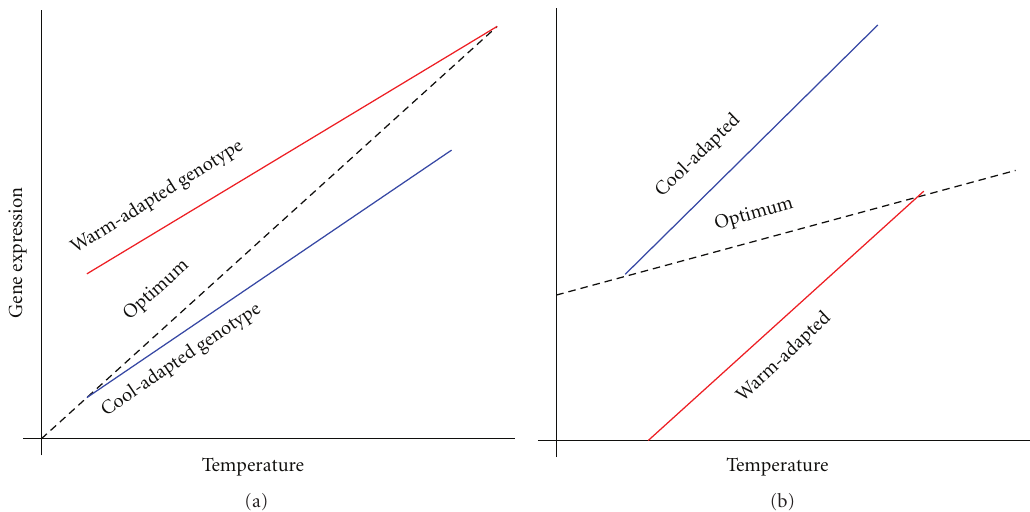
Figure 3: Adaptive and nonadaptive reaction norms. These hypothetical examples suppose that the optimum expression level for some gene increases with temperature and that increased temperature induces increased expression of the gene. (a) Plasticity is adaptive when it keeps expression closer to the optimum than it would be if expression, were constant across temperatures. (b) Plasticity is nonadaptive (maladaptive, in this case) when induced changes in a new environment take expression further from the optimum than it would be if it had remained constant. (b) is an example of countergradient variation, in which genetic di ff erences cause cool-adapted genotypes to have higher gene expression than warm-adapted genotypes at the same temperature. The result is overexpression by cool-adapted genotypes transplanted to warm